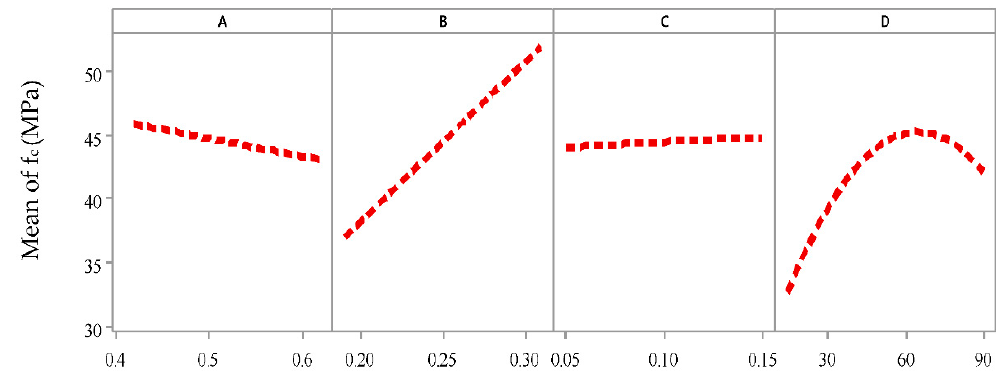
Figure 9. The main effect of continuous variables on response value. A is water/binder ratio, B is binder/aggregate ratio, C is CNA/(CNA+PLC), and D is curing age (d).